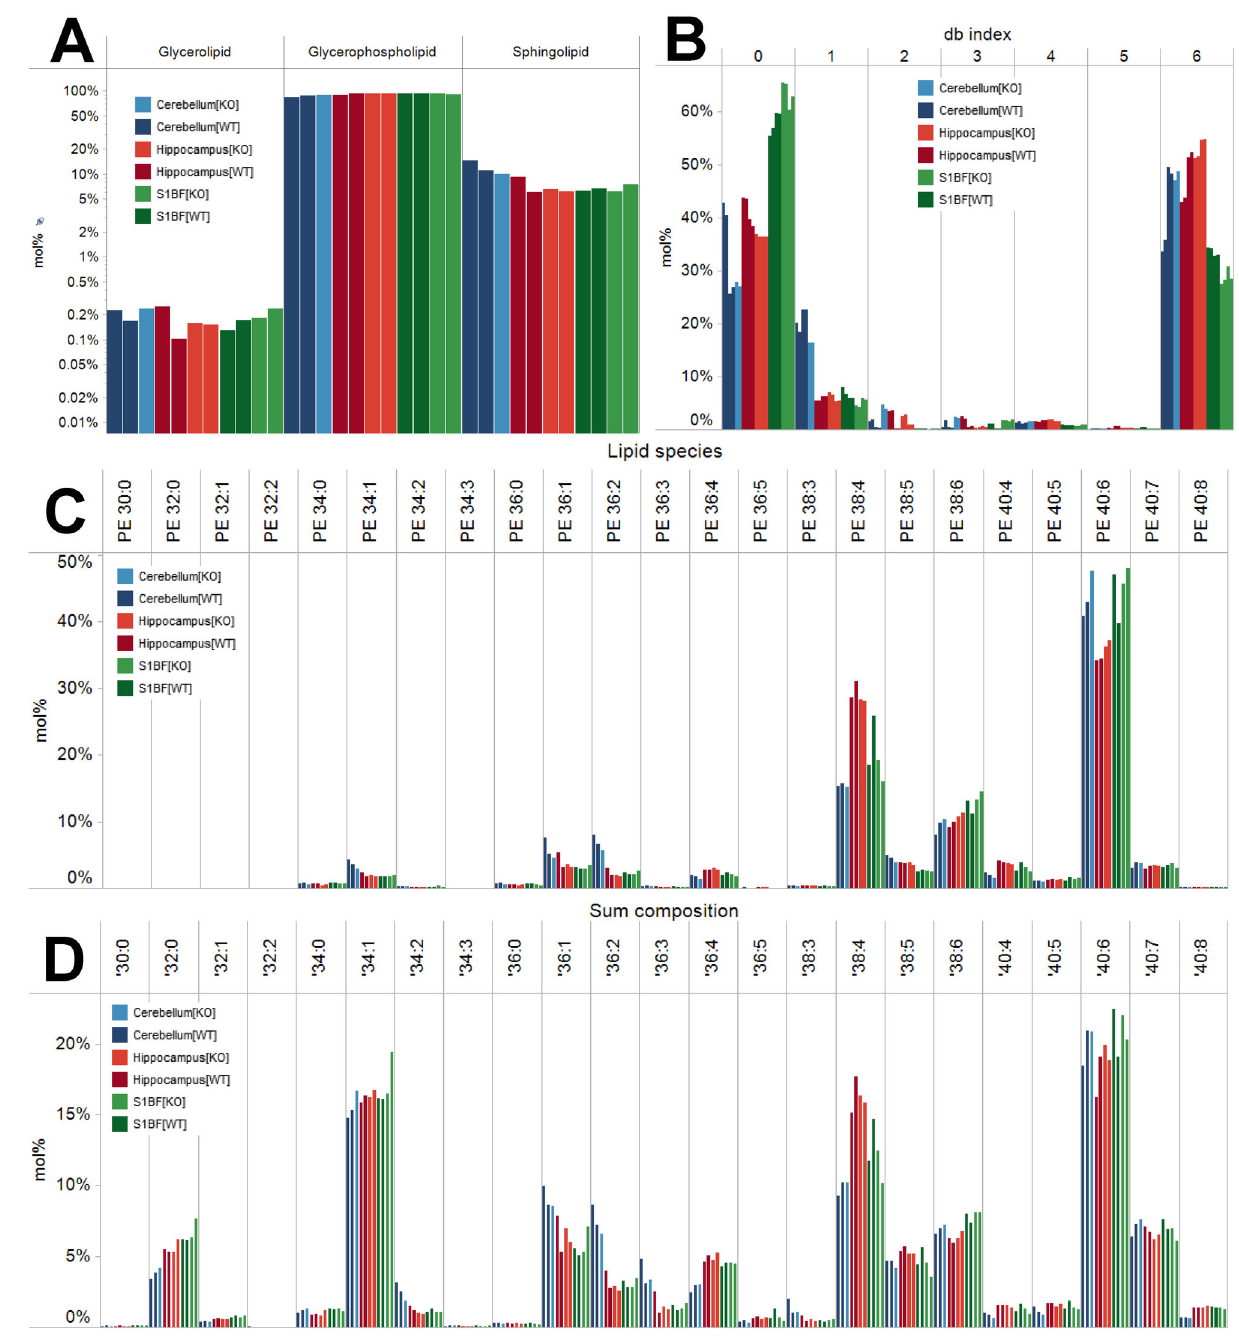
Figure 6. Lipidome visualization using different display formats. ( A ) mol% lipid category. Notice that the y-axis is logarithmic. Data is displayed as the average of the two technical replicates per sample. ( B ) mol% of db index of LPS species. Note that histogram include plot for both technical replicates. ( C ) mol% of PE species. Data is displayed as the average of the two technical replicates per sample. ( D ) mol% of all GPL species. Data is displayed as the average of the two technical replicates per sample. Notice that data for only one sample of cerebellum from knockout mice is available due to lack of spiked internal standards as outline in the section “Application of the ALEX software framework”. This neurolipidomics dataset is available as supporting information (Data S2).